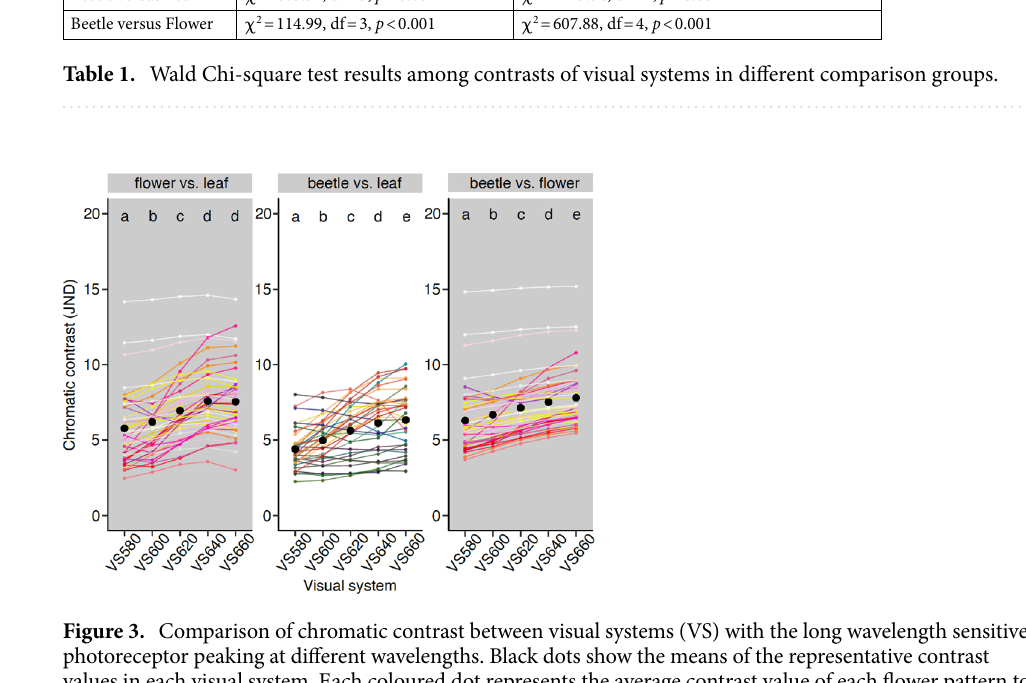
The presence of a long wavelength sensitive receptor improved the contrast of beetles against leaves. In this comparison (‘ beetle vs. leaf ’), there was no significant difference between UML, USL, and USML (all p = 1.00; Fig. 2) and USM had a significantly lower contrast value than the other three visual systems by around 29% (all p < 0.001). Additionally, we found no advantage to tetrachromacy over trichromacy where USL had the same contrast values as USML for all comparison groups (‘ flower vs. leaf ’, p = 0.12; ‘ beetle vs. leaf ’, p = 1.00; ‘ beetle vs. flower ’, p = 0.28; Fig. 2). Models where changes in the spectral absorbance of the long wavelength sensitive receptor were due to modi- fied opsin sequences rather than the optical influence of screening pigments showed qualitatively similar results for the comparison of beetles against leaves, with a long wavelength sensitive receptor improving contrast values (Fig. S12). However, only the presence of a short wavelength sensitive receptor (rather than both short and long wavelength sensitive receptors together) improved contrast values of beetles against flowers and flowers against leaves (full results in Supplementary Information 8). The contrast values obtained from the four visual systems in the models using civil twilight showed differ- ent patterns and were substantially lower than the values obtained from the models using daylight (Fig. S9). In twilight illumination, USM performed significantly worse than the other visual systems and the tetrachromat performed significantly better than the trichromats but all contrast values were below 2 JND (Supplementary Information 7). There were two white and one pink flower ( Eremophila laanii , Actinotus helianthi , and Chamelaucium unci- natum ) with exceptionally high contrast values when compared against beetles and leaves (Fig. 2). Such high contrast was the result of a steep rise in reflectance at ca. 400 nm in these three flowers, which was not present